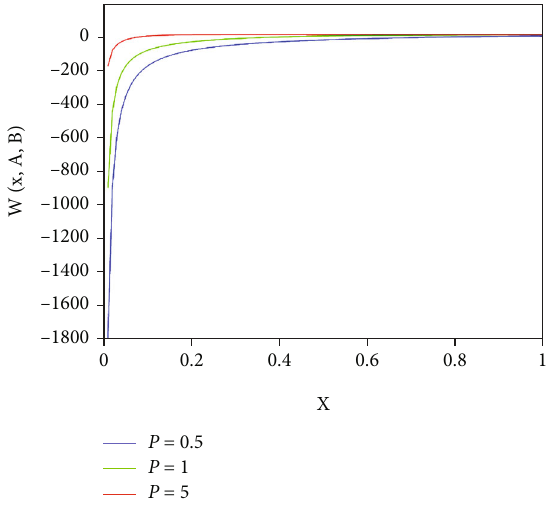
Figure 1: Superpotential W ð x , A , B Þ ( m = 2, n = 3, A = − 28 : 5, B = 18